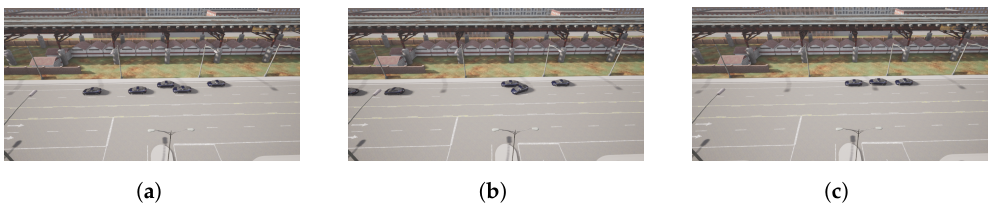
Figure 18. Follower 2 parking process. ( a ) Follower 2 in platoon. ( b ) Follower 2 parking. ( c ) Follower 2 parked.